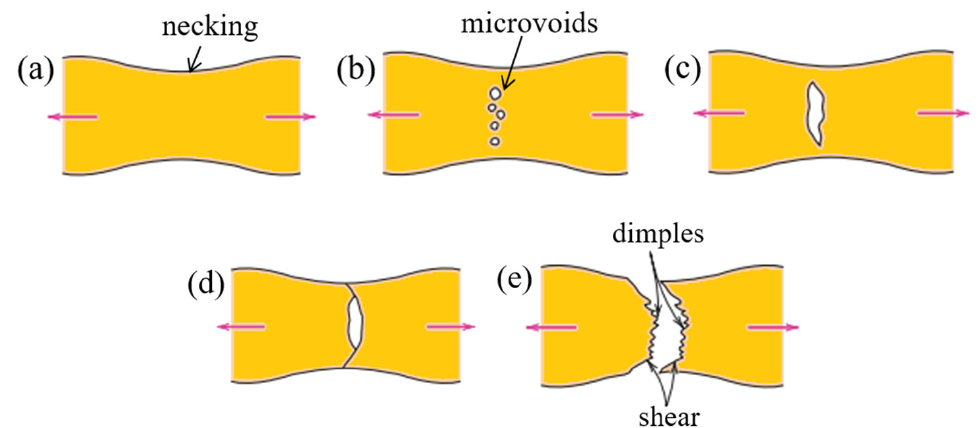
Figure 10. Stages in the ductile fracture. ( a ) Initial necking. ( b ) Small cavity formation. ( c ) Coales- cences of cavities to form a crack. ( d ) Crack propagation. ( e ) Final shear fracture.